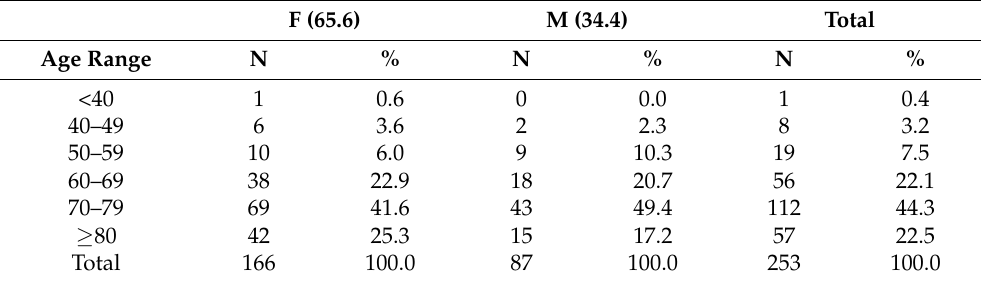
Table 1. Demographic age information divided by gender.